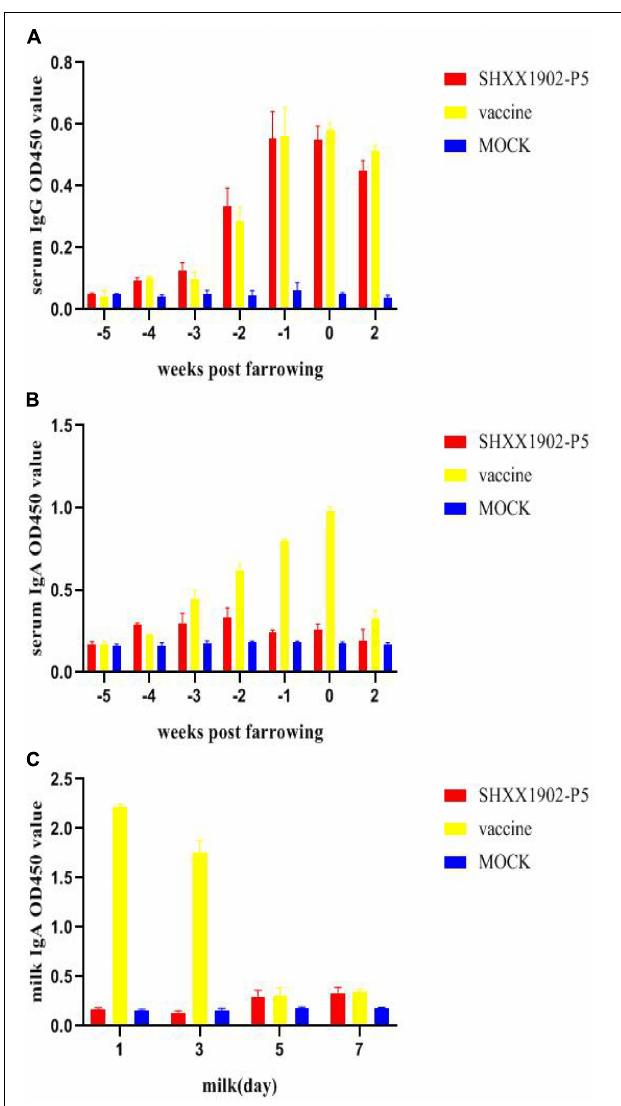
FIGURE 5 | Levels of PEDV-specific IgG and IgA antibodies in the serum and IgA antibodies in the milk of sows after immunization with different strains. Levels of PEDV-specific IgG antibodies in the serum (A) , IgA antibodies in the serum (B) , and IgA antibodies in the milk (C) were determined with ELISAs. All data are shown as means ± SD.